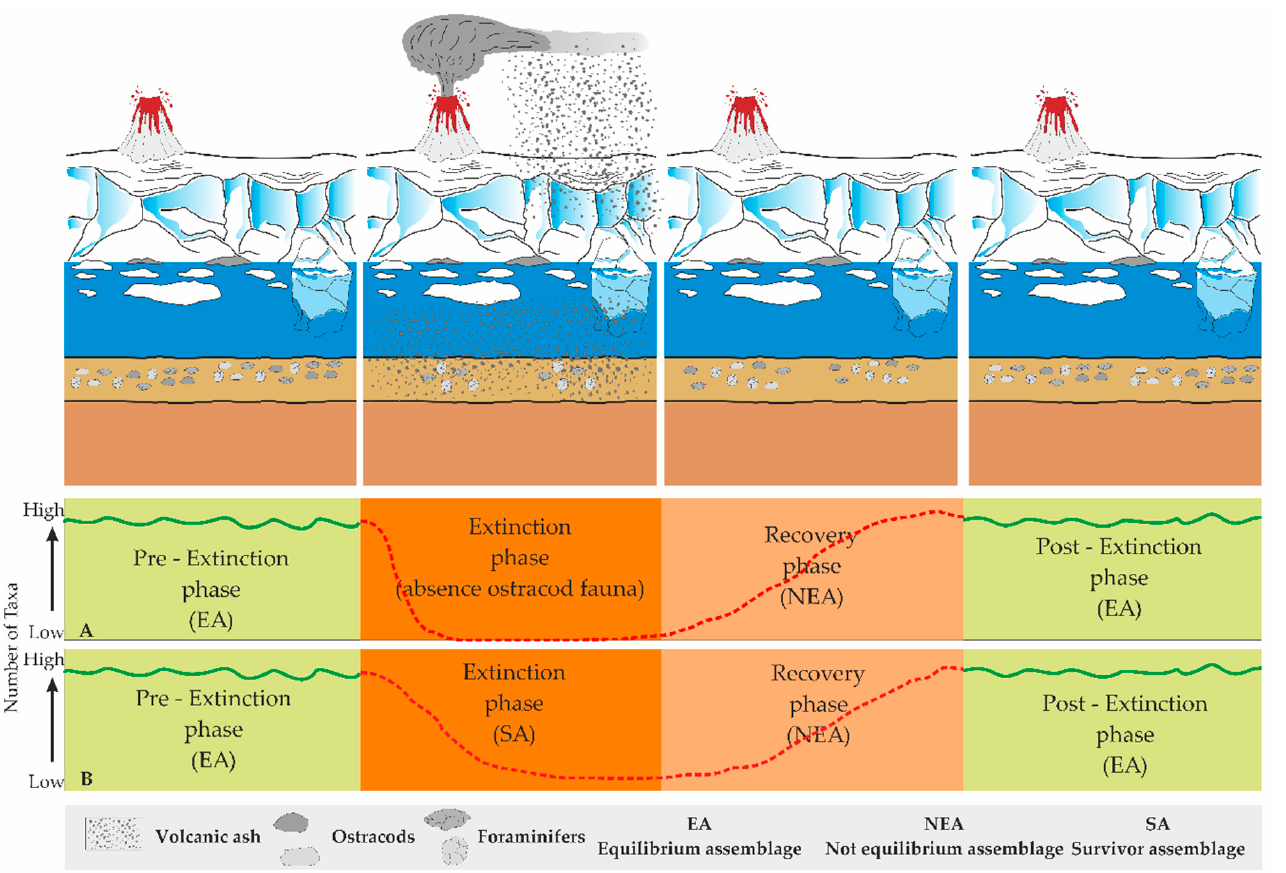
Figure 5. Conceptual scheme, modified from [92], summarising the different stages of extinction, recovery, and return to pre-crisis conditions recorded in the ANTA02-NW2 core sediments. The lower part of the figure highlights the different reactions to volcanic ash deposition of the ostracod ( A ) and foraminifer ( B ) assemblages. For details, see the legend in this